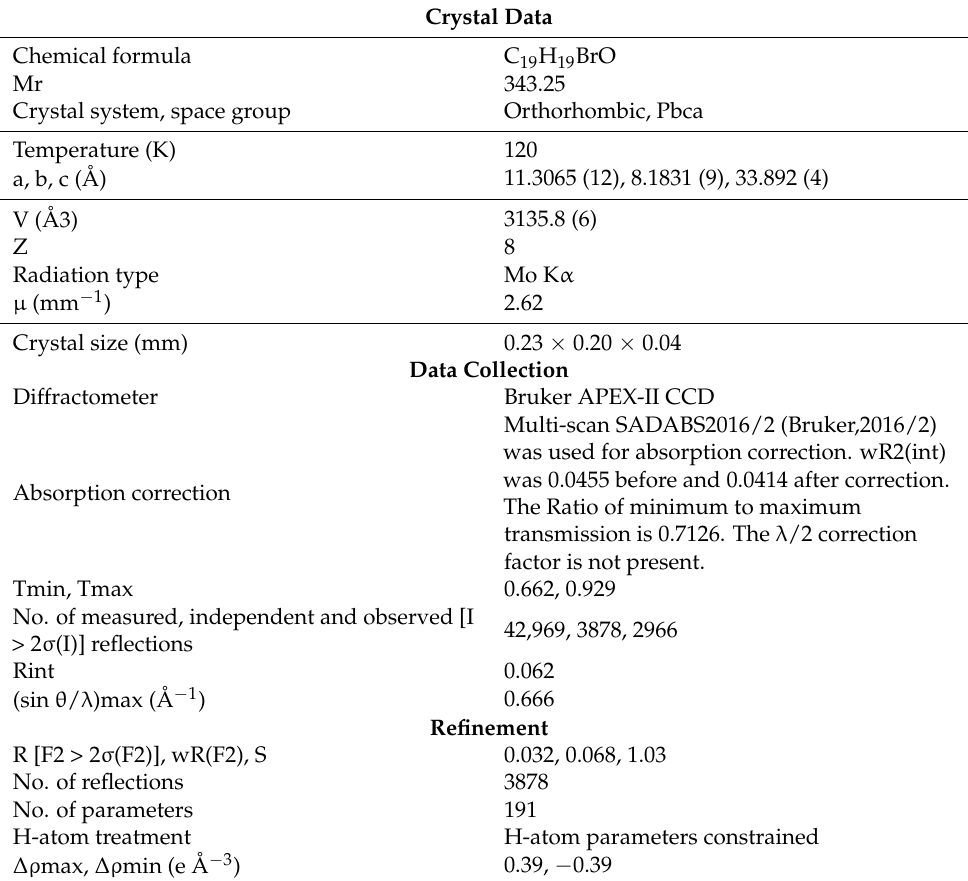
Table 2. Crystallographic parameters for BBP.